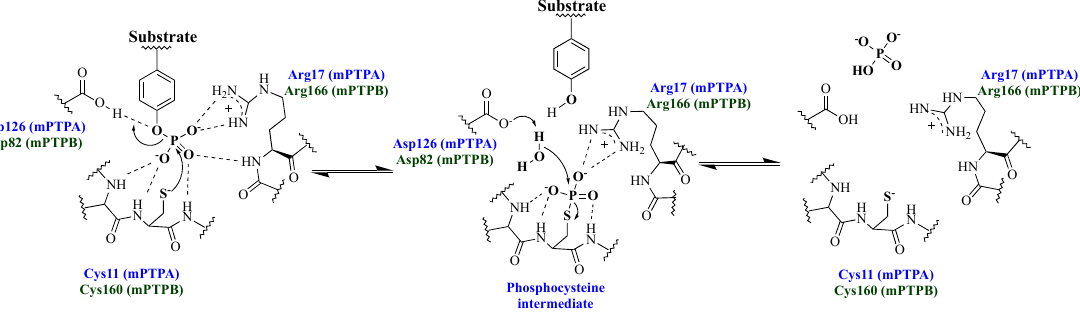
Figure 1. The dephosphorylation mechanism of protein tyrosine phosphatases with mPTPA and mPTPB as examples. The residues are labeled in blue for mPTPA and in green for mPTPB. The dianionic phosphotyrosine (pTyr) binds to the positively charged active site of PTPs. The active site cysteine thiol (Cys11 in mPTPA, Cys160 in mPTPB) possesses a pKa of ~5 and is predominantly in the thiolate form at neutral pH. When binding to pTyr substrates, aspartic acid, acting as a general acid (Asp126 in mPTPA, Asp82 in mPTPB), moves closer to the active site to neutralize the leaving group and facilitates nucleophilic attack by cysteine at the phosphorus atom of the substrate. The dephosphorylated substrate leaves the active site, giving a water molecule an opportunity to attack at the phosphocysteine intermediate to regenerate the cysteine thiolate.